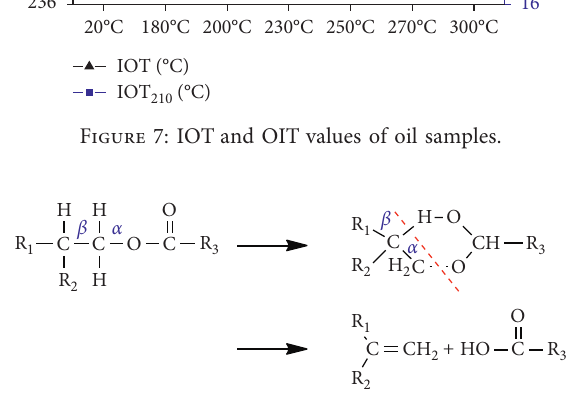
Figure 8: Thermal pyrolysis mechanism of